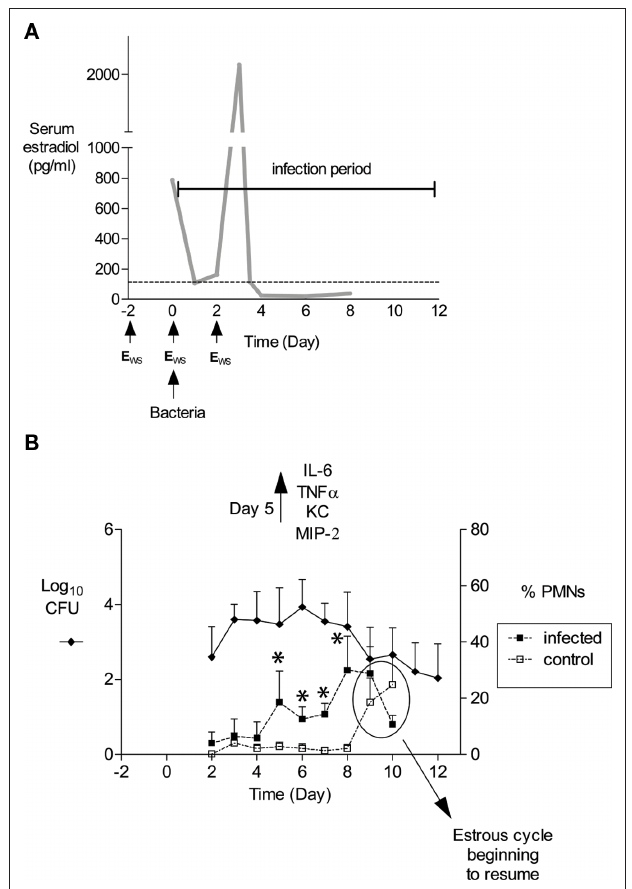
Figure 1 | Schematic of mouse infection protocol and characteristics of infection. (A) In our laboratory, mice are treated with 17 β -estradiol to promote Gc infection by implantation of a slow-release pellet under their skin (Jerse, 1999; not shown) or subcutaneous administration of water-soluble estradiol (estradiol ; 0.5 mg) on days − 2, 0, and 2 (Song et al., 2008). The benefit of ws using estradiol is that serum estradiol concentrations return to physiological ws levels within 24 h after administration, and in our treatment protocol, Gc is not exposed to abnormal levels by day 3 of infection as shown. The dotted line corresponds to estradiol levels in normal proestrus stage mice (Dalal et al., 2001) Mice are inoculated with bacteria on day 0. Not shown is the antibiotic treatment regimen, which has been adjusted over time due to changes in breeders and husbandry practices. Currently, streptomycin sulfate (Sm; 2.4 mg) and vancomycin hydrochloride (0.4 mg) are administered via intraperitoneal (i.p.) inoculation twice daily until day 2 of the infection period. Drinking water with trimethoprim sulfate (0.04 g/100 ml water) is used over the course of the experiment, with Sm (0.5 g/100 ml water) added on day 2 of the infection period. (B) An example of the average number of CFU recovered from a single vaginal swab suspended in 100 μl of PBS (left axis) and percent of PMNs in stained vaginal smears (right axis) is shown. Mice ( n = 6) in this experiment were inoculated with 10 6 CFU of strain FA1090. In published (Packiam et al., 2010) and unpublished data from our laboratory, increased levels of proinflammatory cytokines and chemokines are detected on day 5 of infection as shown, which corresponds to the influx of PMNs in infected mice. Asterisks denote time points at which the percentage of PMNs in infected mice (dashed lines, solid squares) was significantly higher than that in mice given PBS (dashed lines, open squares). Increased PMNs were observed in control mice on days 9 and 10, which is due to the effects of the estradiol wearing off and the resumption of the estrous cycle. Mice were colonized for an average of 9.9 days in this 12-day experiment. This figure was constructed with combined data reported in (Song et al., 2008; Packiam et